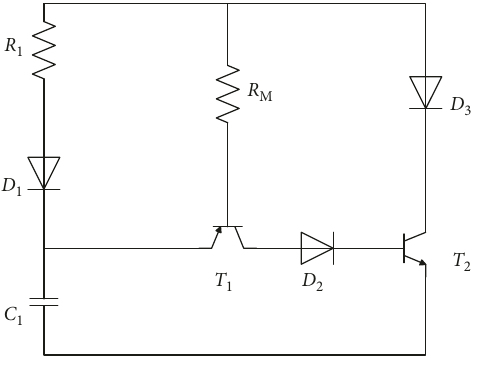
Figure 5: Passive peak detection module.